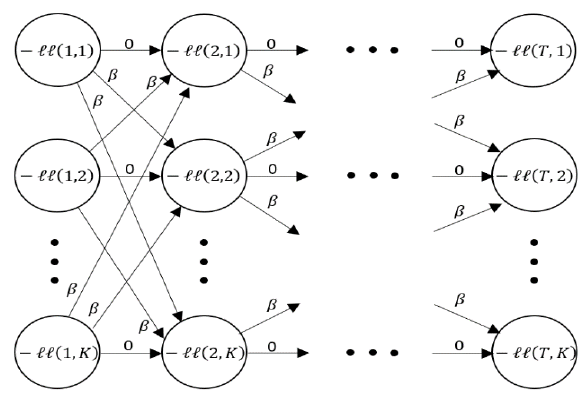
Figure 10. Graphical formulation of the clustering assignment problem based on [3].